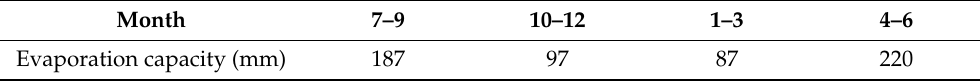
Table 2. Monthly evaporation in the study area.